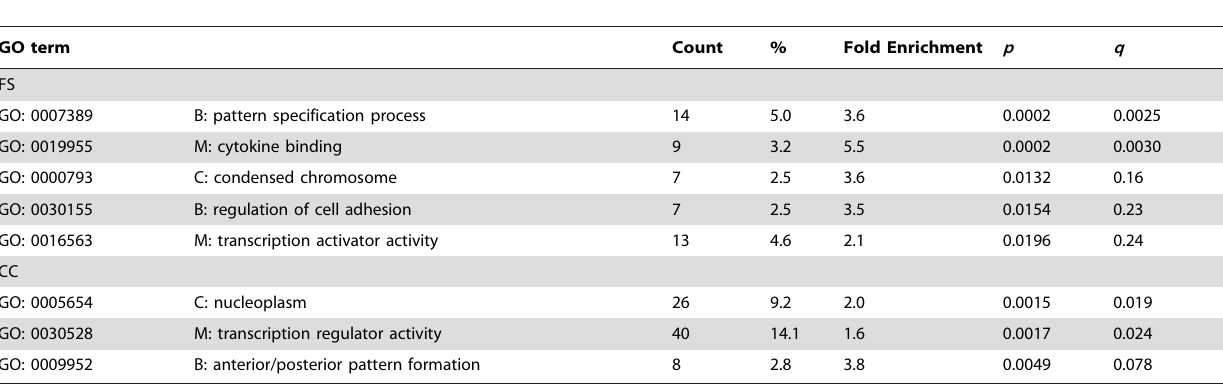
Table 4. GO term enrichment analysis based on the results from the meta-analysis of gene-based GWAS in European and African American